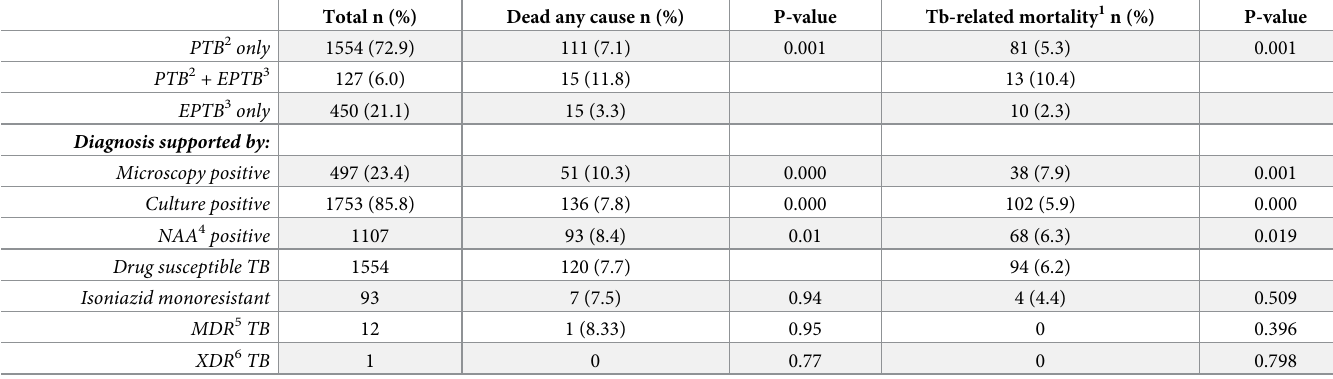
Table 2. TB-related mortality 1 and overall mortality, by site of TB and diagnostics; Denmark 2009–2014.